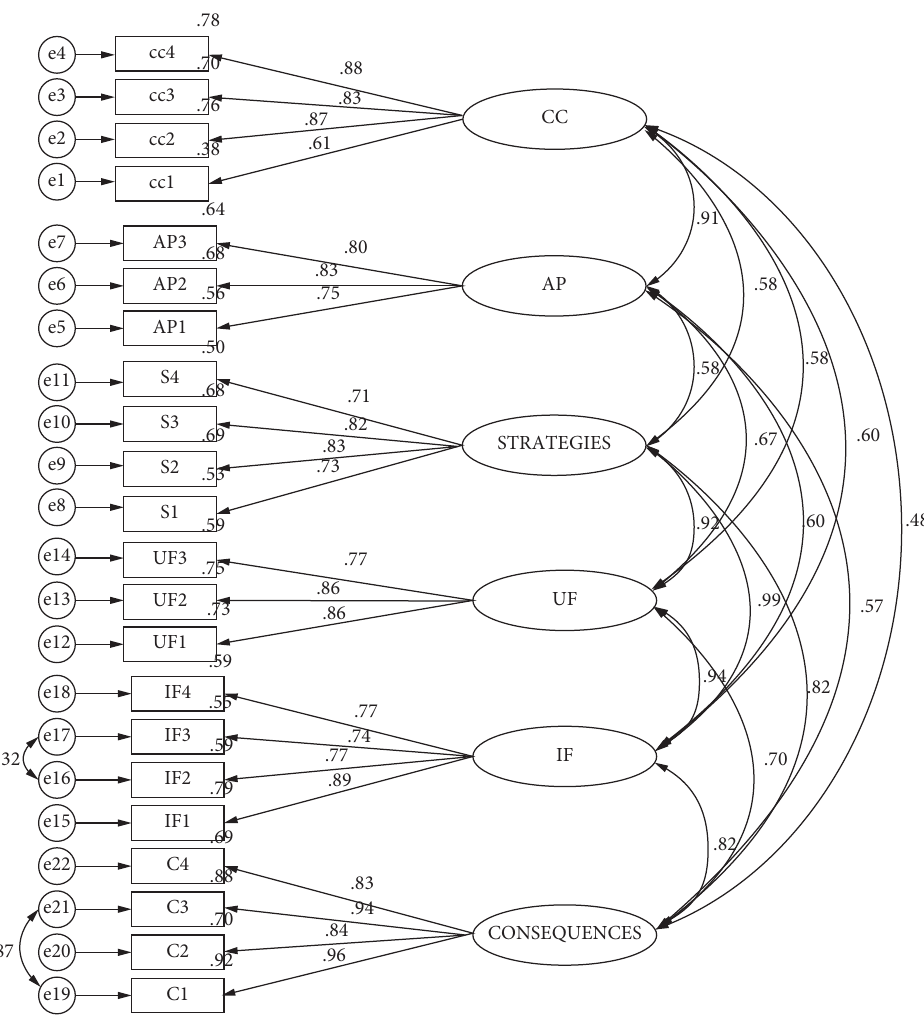
Figure 2: Te total measurement model of the policy-making model of biomass energy development education in agriculture. Table 5: Statistical results of the biomass energy development education model in agriculture.